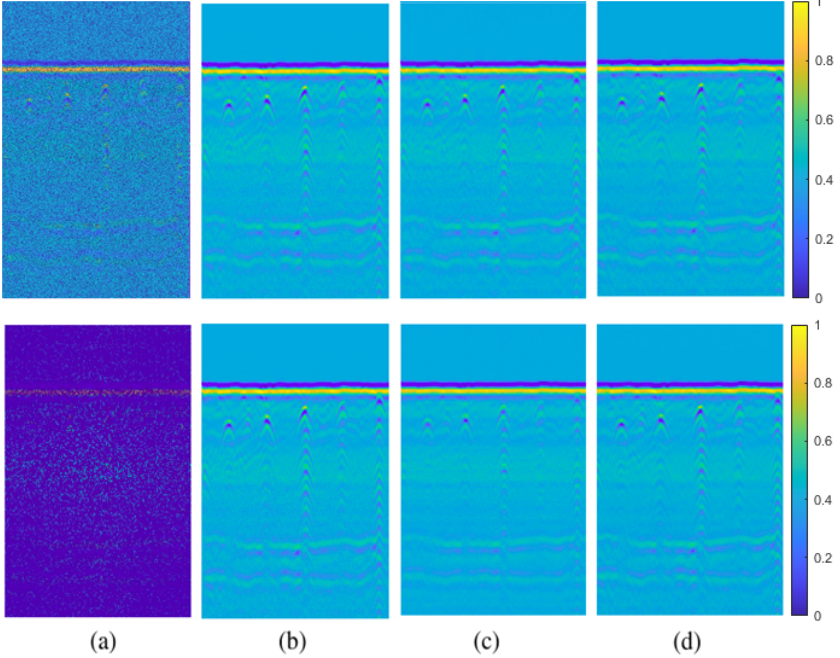
Figure 21. First row 30% pixel-wise and second row 80% missing data case for real data-II: ( a ) GPR image with missing entries, ( b ) original GPR image, recovered images by ( c ) NNM, ( d ) DIP.